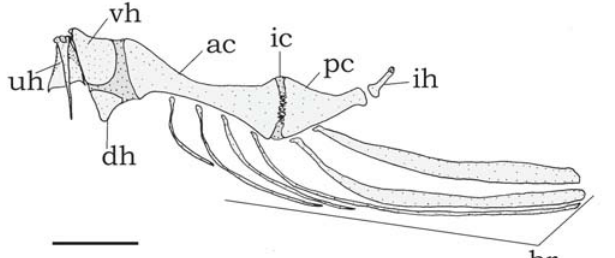
Fig. 4. Right hyoid arch of Tatia gyrina , INPA 20971, 28.0 mm SL. Medial view. Abbreviations: ac , anterior ceratohyal; br , branchiostegal rays; dh , dorsal hypohyal; ic , interceratohyal cartilage; ih , interhyal; pc , posterior ceratohyal; vh , ventral hypohyal; uh , urohyal. Scale bar = 1.0 mm.